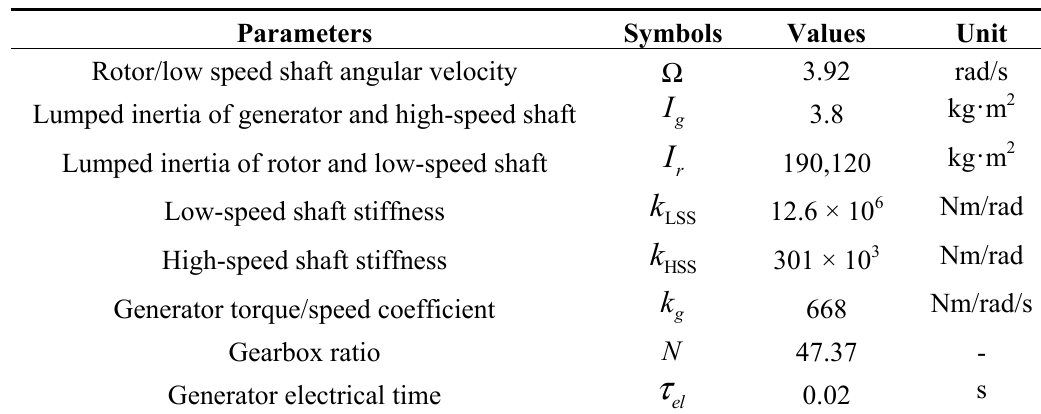
Table 1. Drive train parameters